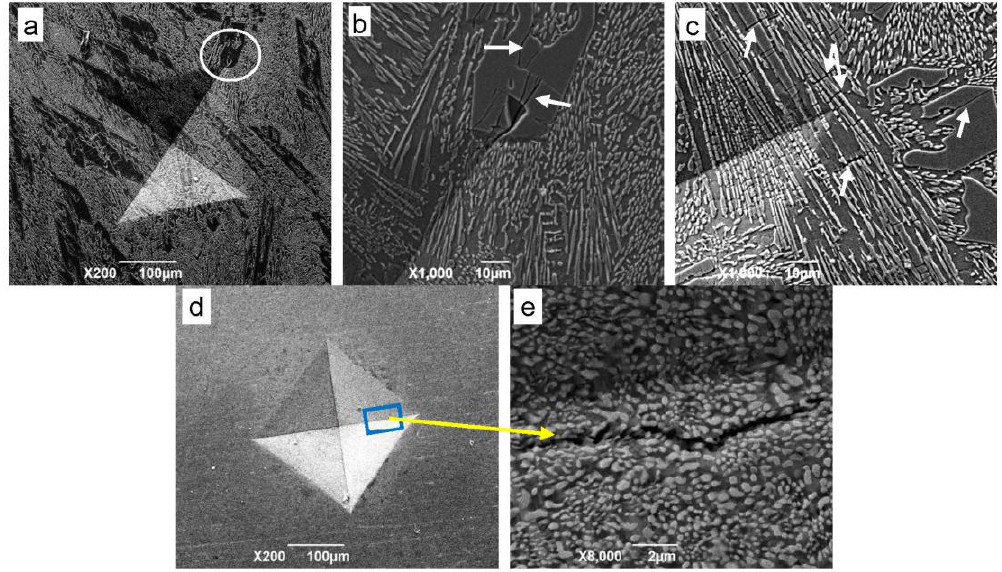
Figure 6. Cracks developed after the indentation test: ( a , b ) at the tip of the indentation, and ( c ) inside and around the indentation (cast material); ( d , e ) a microcrack developed along an edge (laser clad).